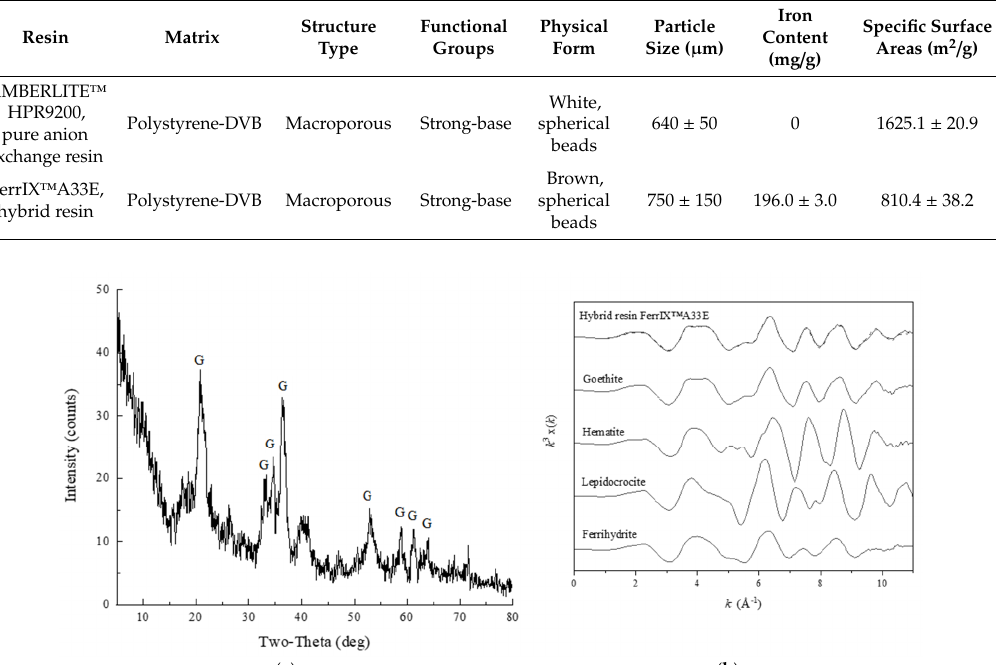
Table 2. General characteristics of the pure anion exchange resin and the hybrid resin used in this study. Resin